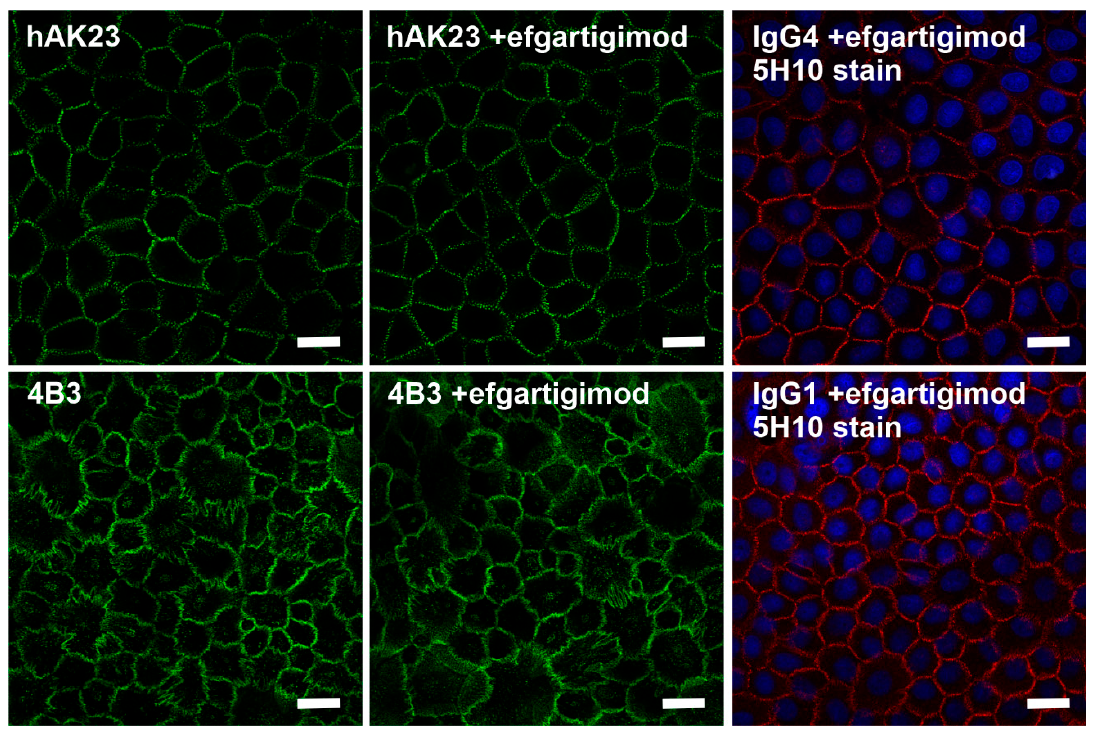
Figure 7. Efgartigimod does not rescue the aberrant Dsg3 staining pattern induced by hAK23 and 4B3. hTert keratinocytes were cultured on coverslips in KGM2 medium with 0.05 mM CaCl 2 for at least three days, and then switched to KGM2 with 2 mM CaCl 2 for 24 h. The cells were either mock-treated, or efgartigimod (25 µg/mL) was applied for 30 min, after which a 24 h treatment with the recombinant antibodies hAK23 (12.5 µg/mL), 4B3 (50 µg/mL), an isotype-matched human IgG4 (12.5 µg/mL) or IgG1 control (50 µg/mL) coupled to Alexa Fluor 488 (green) was initiated. After methanol fixation, the control IgG-treated cells were stained with the 5H10 anti-Dsg3 antibody, detected with a fluorochrome coupled secondary antibody (anti-mouse Alexa Fluor 546, red). Representative images from one out of at least three independent experiments are shown. Scale bar: 20 µm.